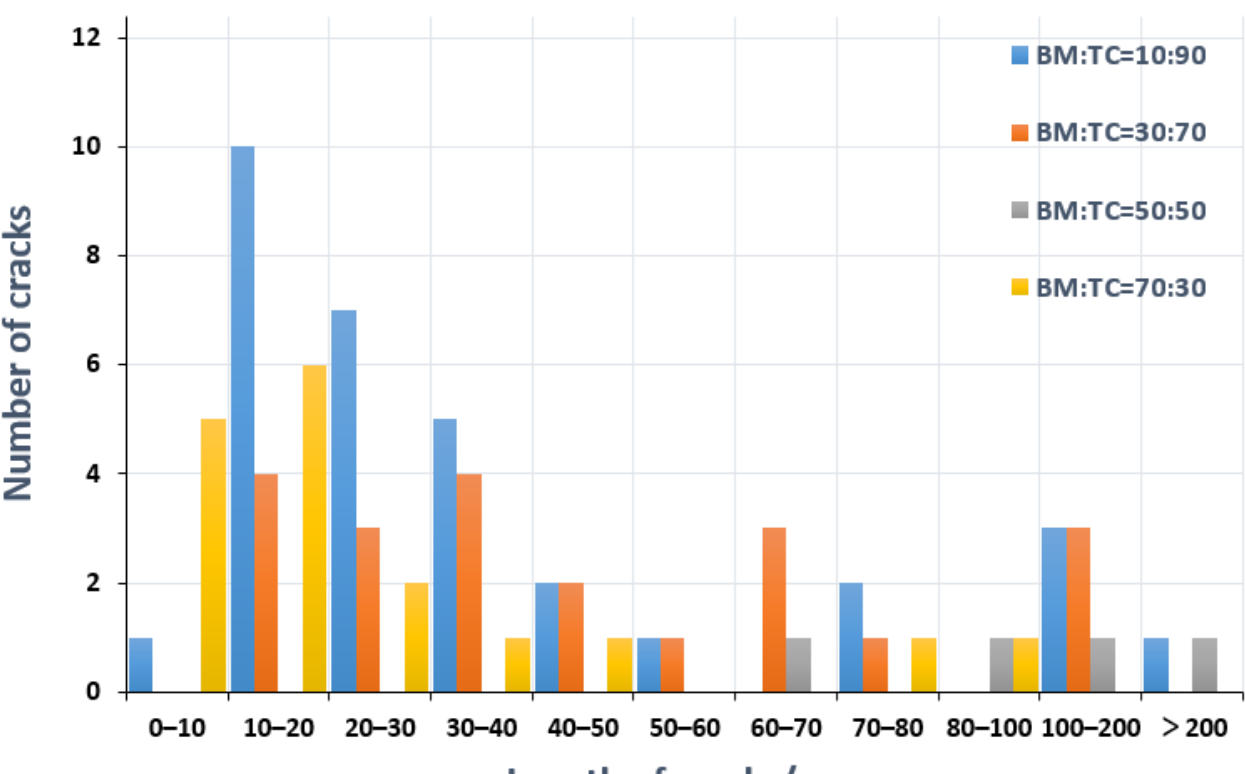
Figure 7. Distribution of crack length in samples with different BM:TC.